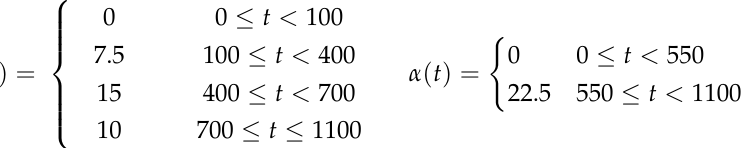
Figure 14. Design criteria for parameter 𝑎 .